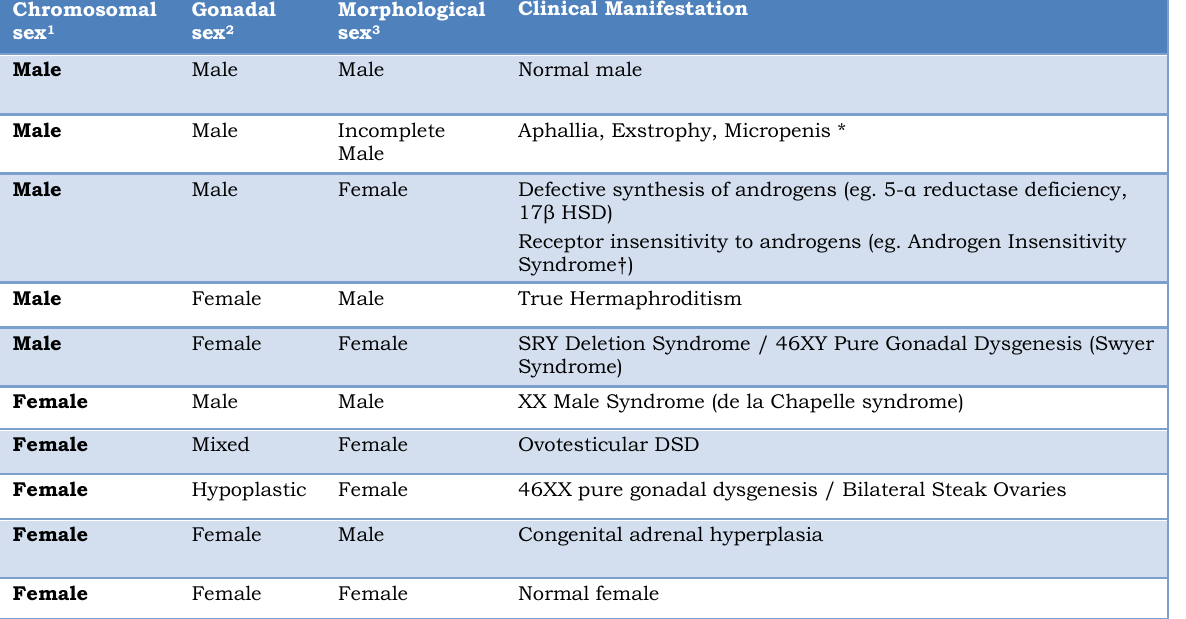
Table 1: Clinical Manifestation of Discordance among Sex